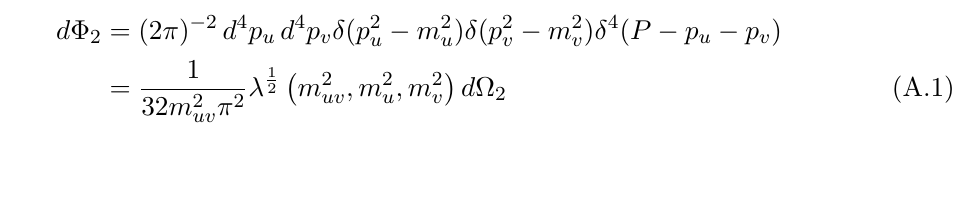
Figure 12 . Performance comparison of the regular veto algorithm using overestimate c algorithm 2 using overestimate c . On the left, the computation time to shower 10 4 RAMBO- linear generated events of N electron-positron pairs is compared. On the right, the distribution of weights that results from the application of the shower using algorithm 2 on events with three electron- positron pairs is